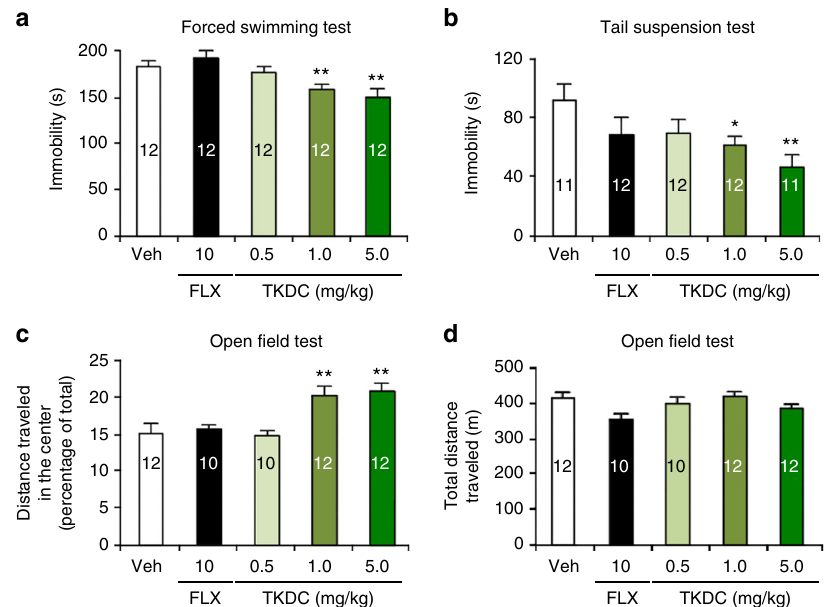
Fig. 7 Chronic administration of TKDC in mice. a Time spent immobile in the forced swimming test after administration of TKDC and fl uoxetine (FLX) [one-way ANOVA with post hoc LSD test, F (4,55) = 4.20]. Veh indicates the vehicle-treatment group. TKDC was administered at doses of 0.5, 1 and 5 mg kg − 1 . Fluoxetine was administered at a dose of 10 mg kg − 1 . b Time spent immobile in the tail suspension test after administration of TKDC and fl uoxetine [one-way ANOVA with post hoc LSD test, F (4,53) = 2.55]. c Percentage of distance traveled in the center of the fi eld over the total distance traveled after administration of TKDC and fl uoxetine in the open fi eld test (one-way ANOVA with post hoc LSD test, F (4,51) = 3.81). d Total distance traveled after administration of TKDC and fl uoxetine in the open fi eld test (one-way ANOVA with post hoc LSD test, F (4,51) = 2.02). The numbers in the bars indicate the number of cells studied per condition. The results are shown as the mean ± s.e.m; * indicates P < 0.05, ** indicates P < kept as low as possible to reduce noise. Currents were recorded at a pipette potential of+ 80mV. Flow cytometry analysis . CHO-K1 cells were transfected with pFLAG-TREK1 for 24 h. After washed with phosphate-buffered saline (PBS), the cells were disassociated with a non-enzyme cell dissociation solution (Sigma). After 10 μ M TKDC incubation for 20, 40 min and 1h at room temperature, cell surface TREK-1 expression in CHO-K1 cells was analyzed by fl ow cytometry. Transfected cells expressing FLAG-tagged TREK-1 were incubated with monoclonal ANTI-FLAG ® M2-FITC antibody (Sigma). Data were collected with a fl ow cytometer (FACS Calibur, BD Bioscience) and analyzed with Flow Jo. Confocal microscopic analysis of channel internalization . In eight-well chamber (Thermo), CHO-K1 cells were co-transfected with PEGFP-N1-TREK1 and OFP-Rab5a. After 24 h, cells were treated with 10 μ M TKDC for 20min at room temperature and DMSO as control. At the end of incubation, cells were washed with PBS, fi xed with 4% paraformaldehyde and washed with PBS. Images were taken at× 100 with scan zoom 1.74 using Leica SP8 and 3D reconstruction was done using Imaris software (Bitplane) and co-localization analysis was quan- ti fi ed using Imaris software. An automatic threshold of red and green channels was selected. The data represent images taken from 18 different areas ( n = 18).